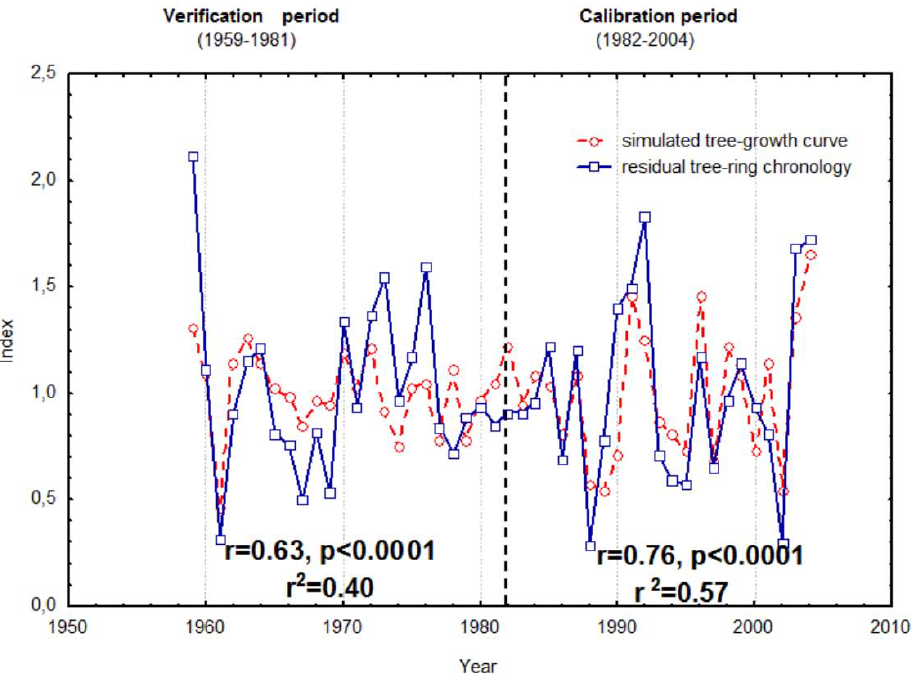
Fig. 2. Variations of initial tree-ring residual chronology (blue solid line) and simulated tree-growth curve (red dashed line) for calibration period (1982–2004) and verification period